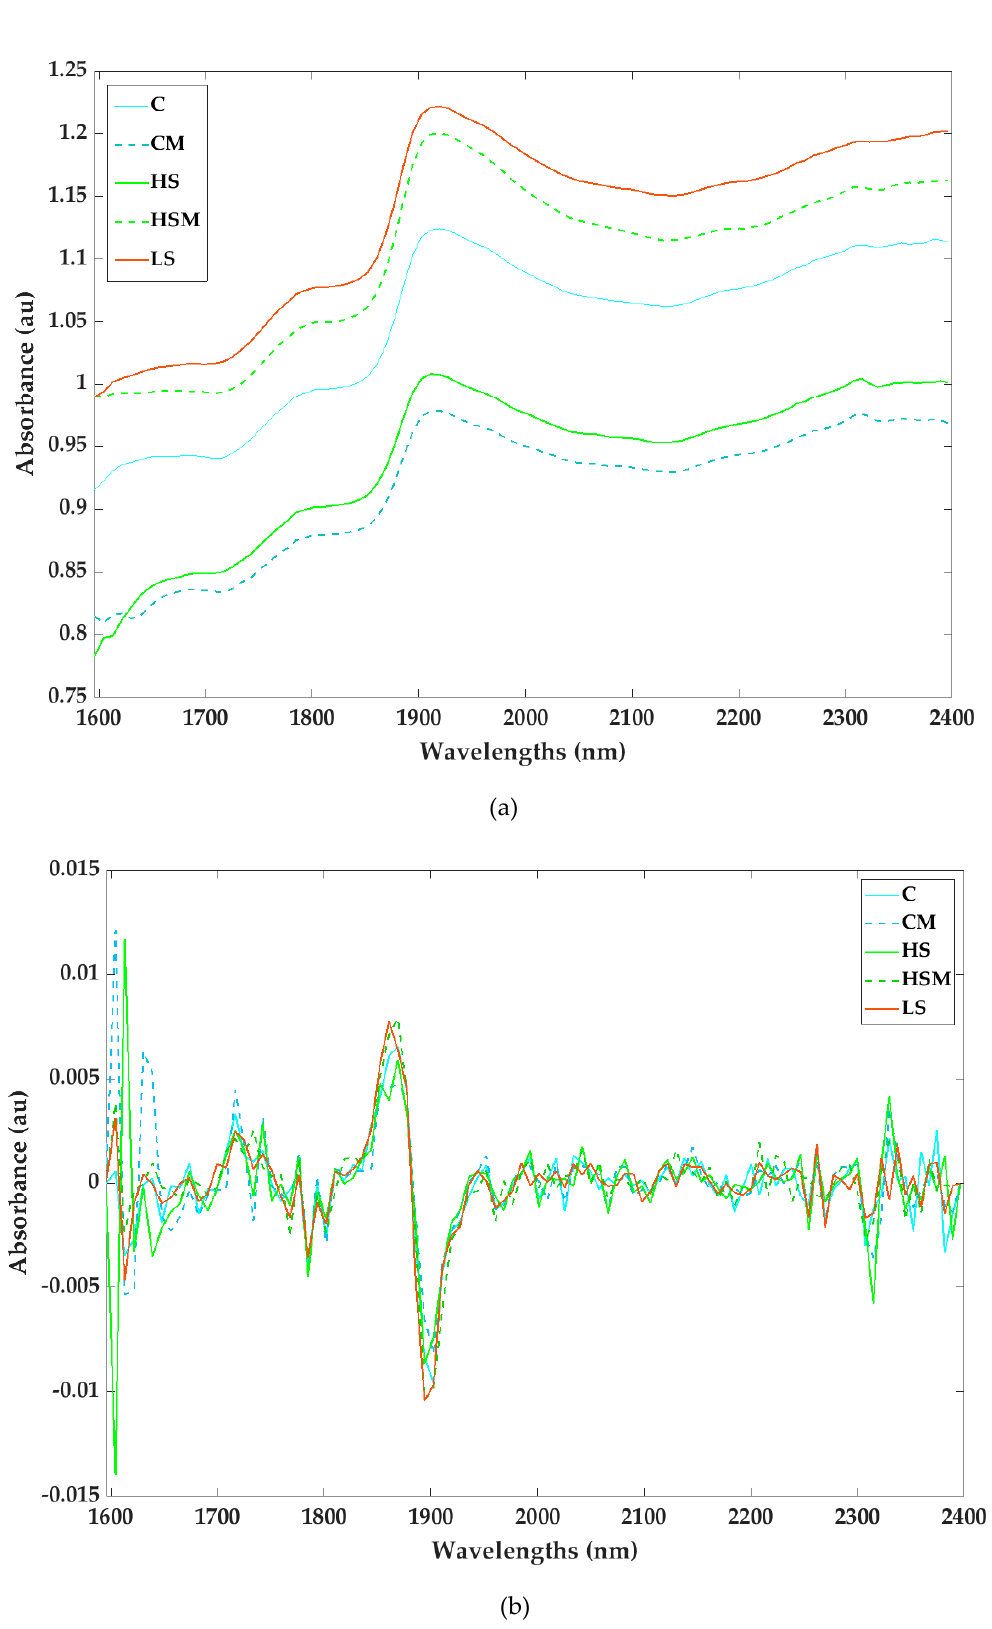
Figure 4. Raw berry absorbance ( a ) and second derivative spectra ( b ) measured with the microPHAZIR TM NIR analyzer for the different smoke and misting treatments. Abbreviations: C = control without misting; CM = control with misting; HS = high density smoke without misting; HSM = high density smoke with misting; and LS = low density smoke.